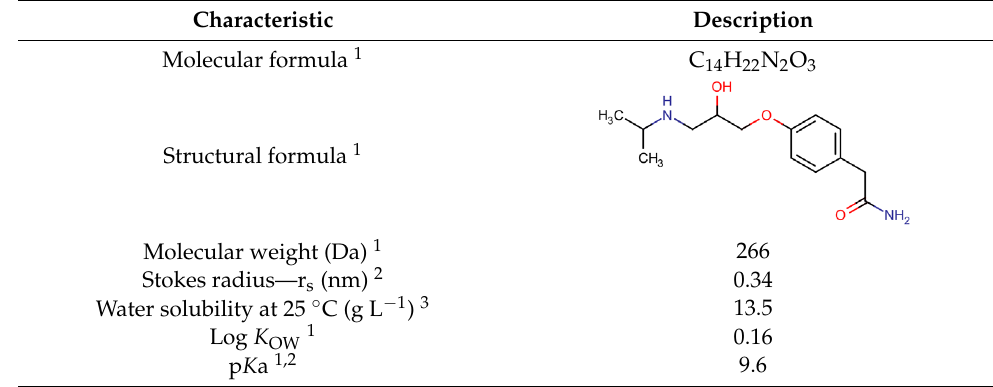
Table 1. Main characteristics of Atenolol (ATN).